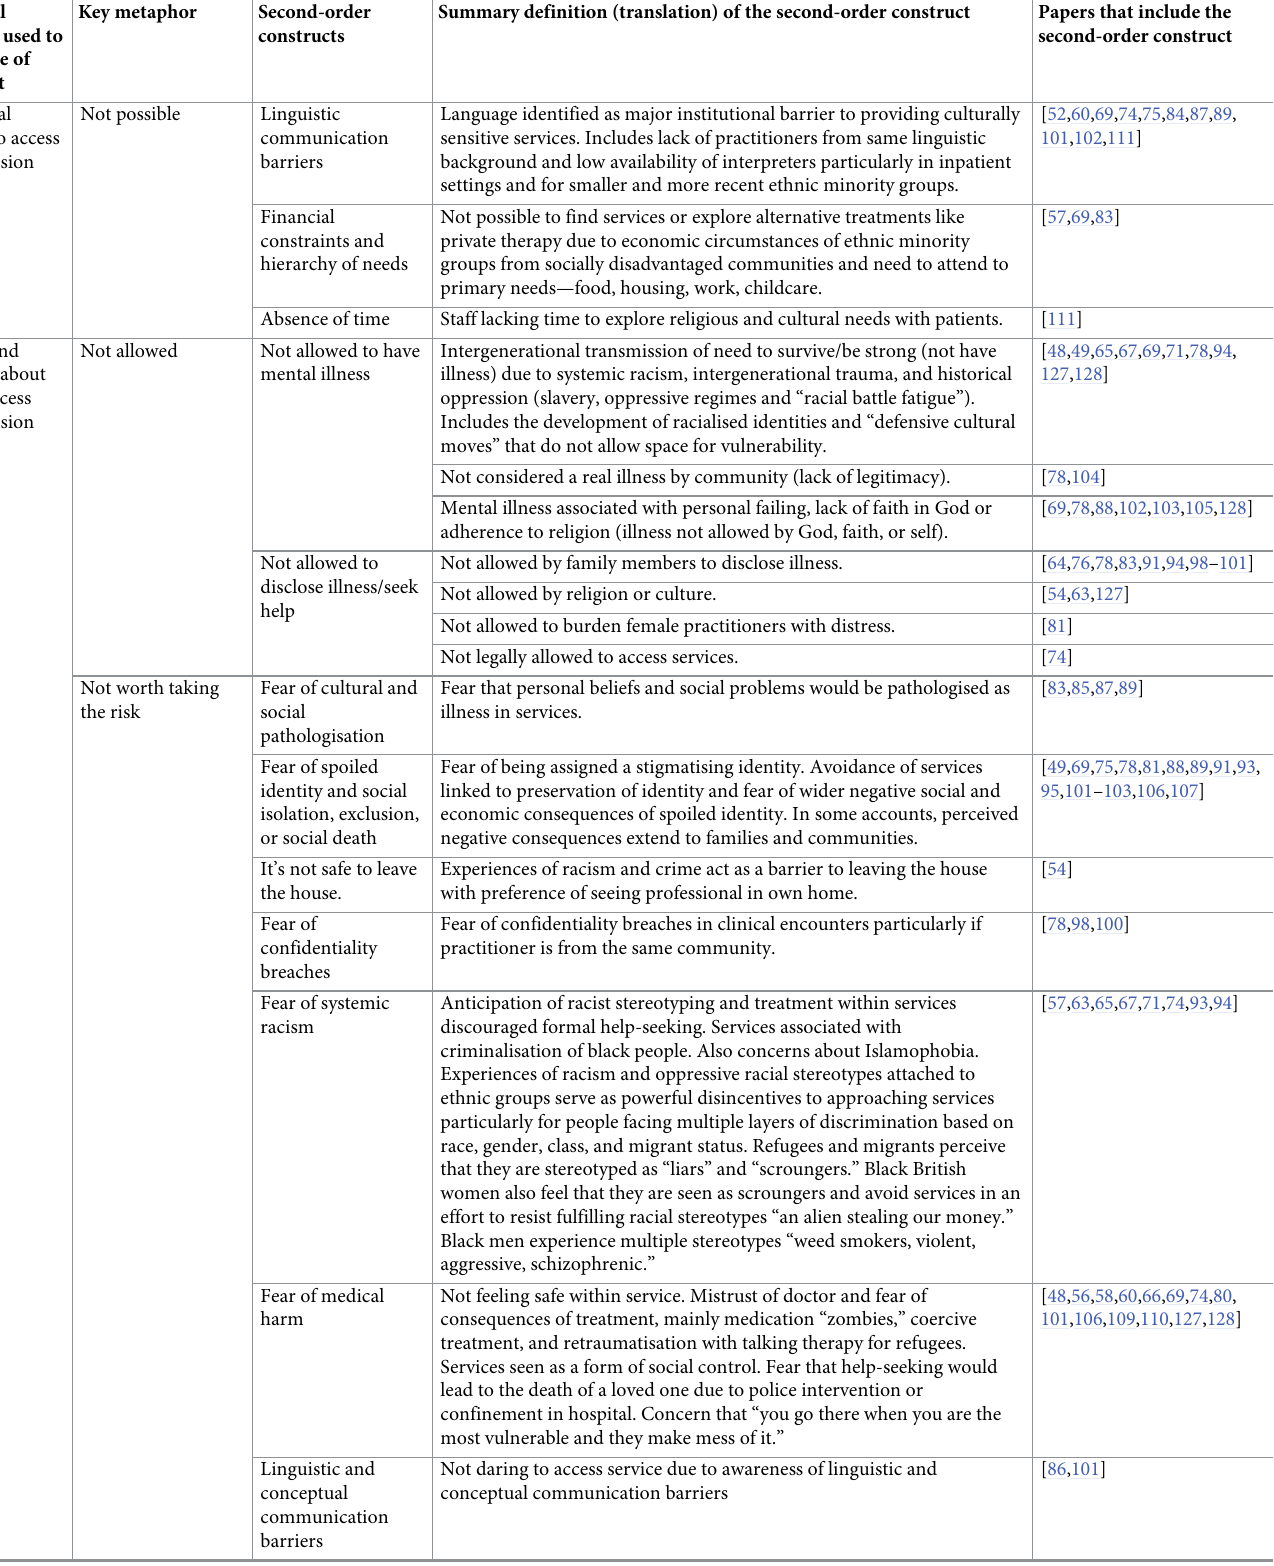
Table 3. Translation of second-order constructs into key metaphors (third-order interpretations). Temporal sequence used to frame line of